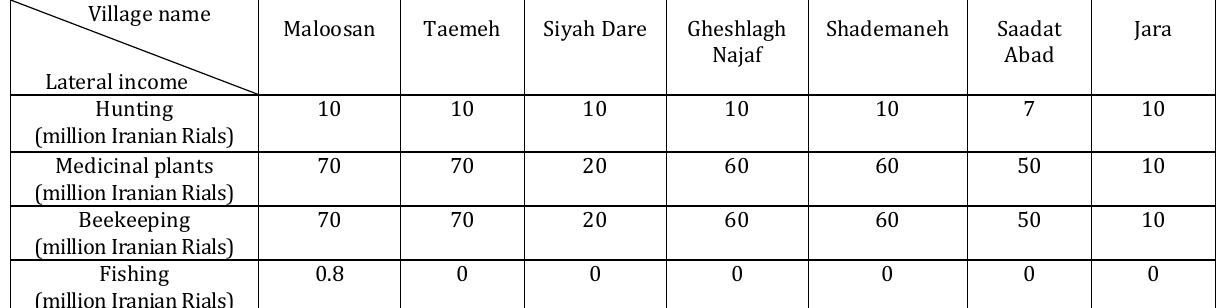
Table 4. Source of lateral income in the study area